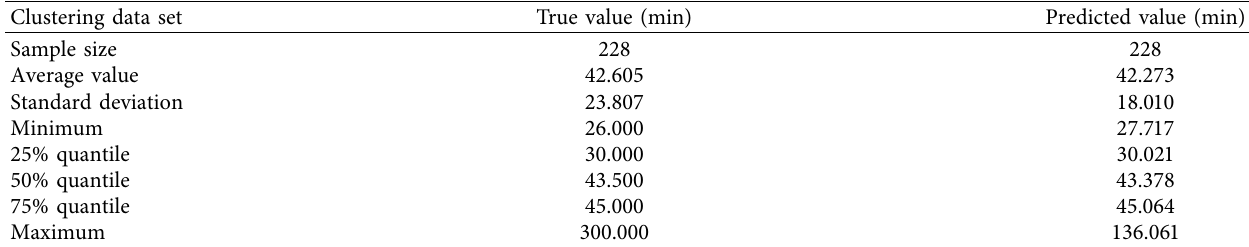
Table 6: Calculation table observed and predicted values of interval